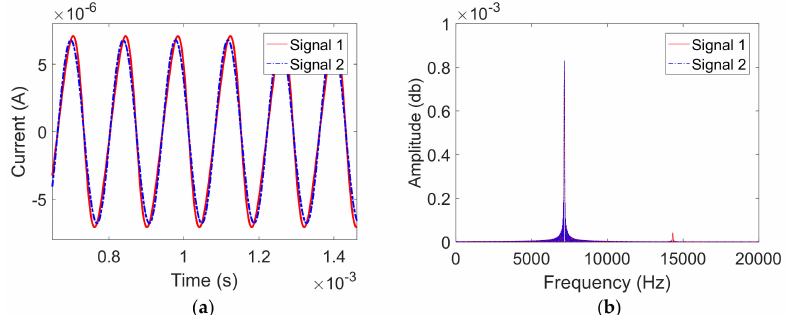
Figure 5. The weak current signal induced by vibration, where Signal 1 is the full form calculated by Equation (6) and Signal 2 is the first order approximation calculated by Equation (7): ( a ) The time domain of such Signal 1 and Signal 2; and, ( b ) The frequency domain of signal 1 and signal